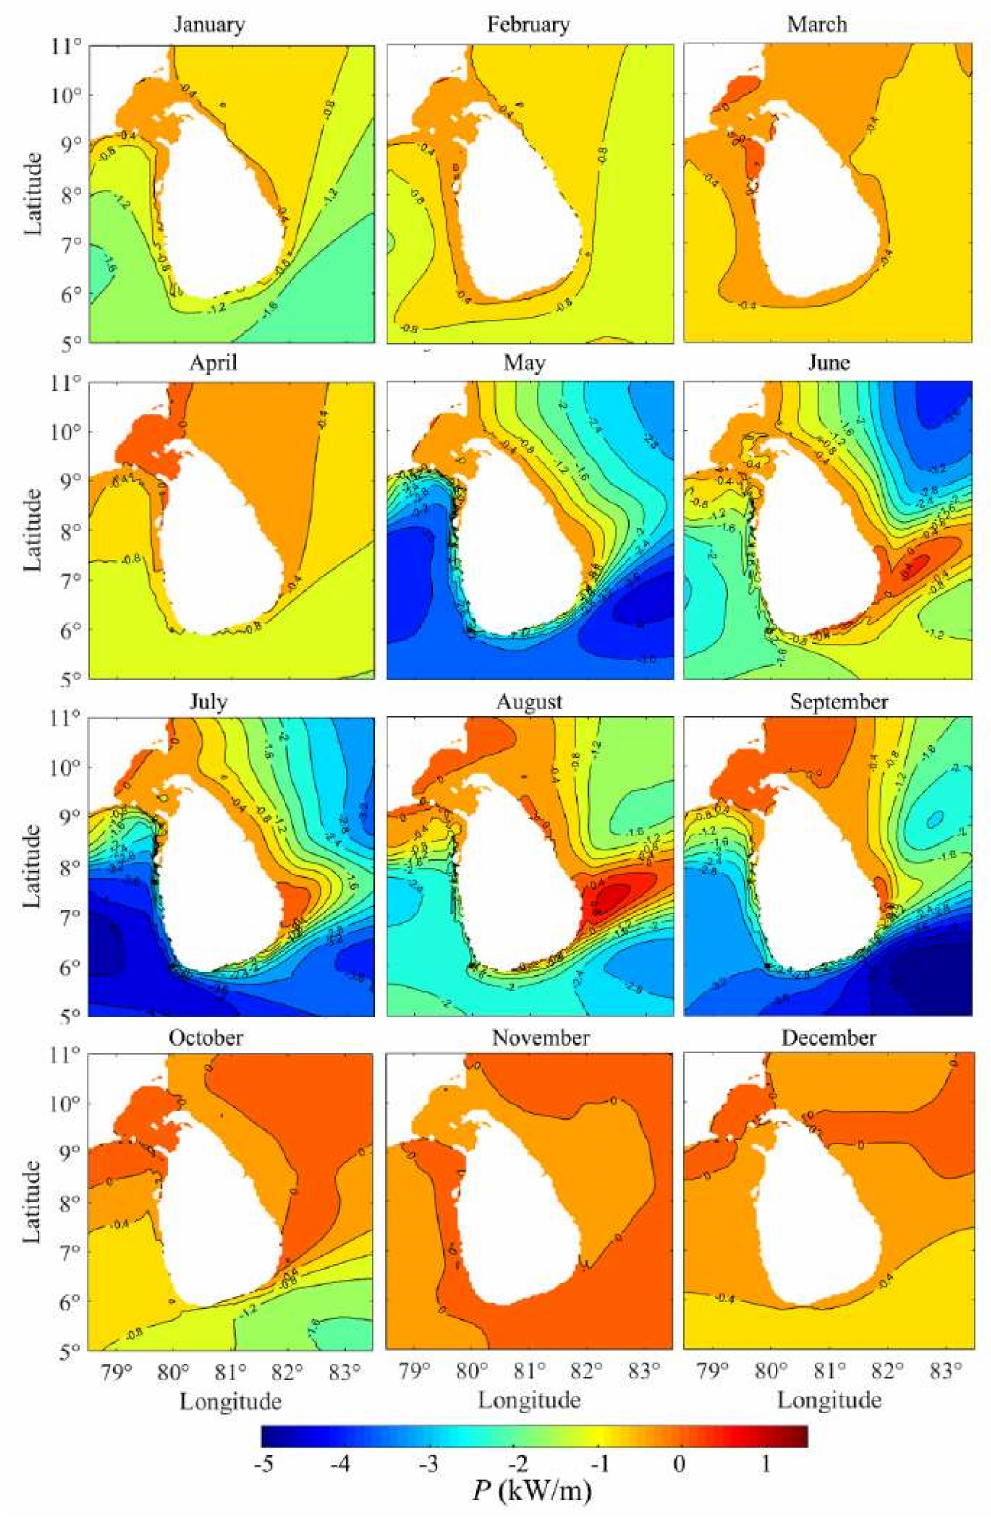
Figure 10. The di ff erence between “future” and “present” monthly averaged wave power at points M1 to M10. The averaging is done over present (1979–2003) and future (2075–2099) 25-year simulation